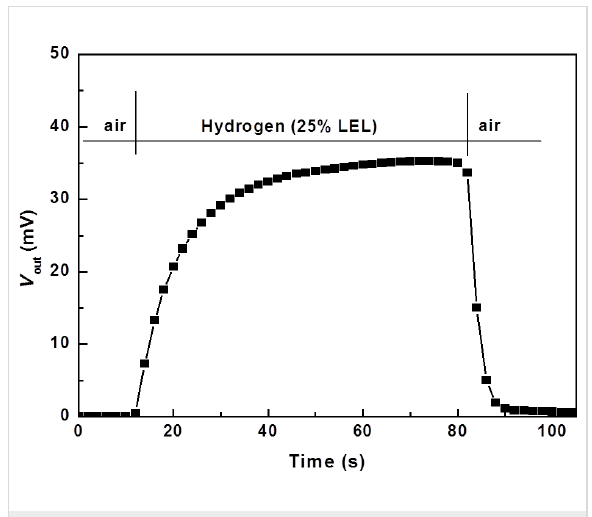
Figure 6: Response characteristics of the hydrogen sensor based on Pd/ZnO